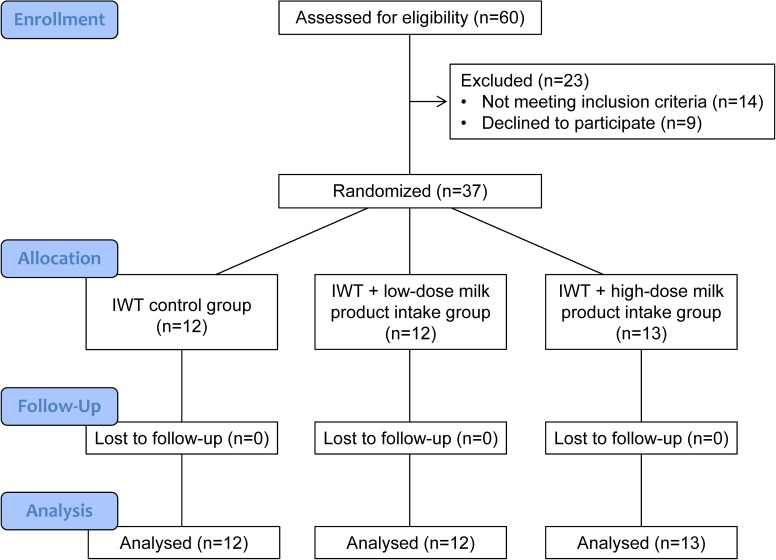
CONSORT flow diagram.IWT, interval walking training.